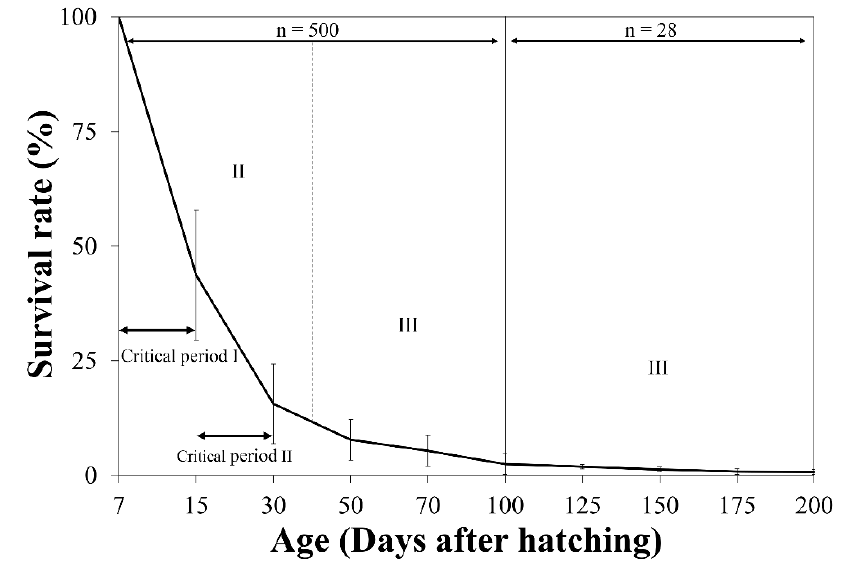
Figure 4. Survival rates of Anguilla japonica larvae during three larval stages from 7 to 200 DAH. Values are means ± SD. Abbreviations: DAH, days after hatching; II, stage II (pre-leptocephalus stage); III, stage III (leptocephalus